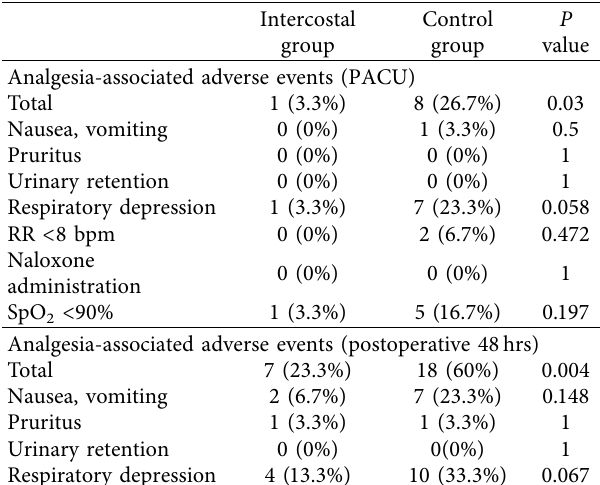
Figure 4: Anxiety scores (SCARED), depression scores (CDI), and quality of life scores (PedsQL4.0) after surgery. ∗∗ P < 0 . 01 and ∗ P < 0 . 05. SCARED, Screen for Child Anxiety-Related Emotional Disorders; CDI, Children’s Depression Inventory; PedsQL 4.0, Pediatric Quality of Life Inventory version 4.0 Generic Core Scales. Table 5: Analgesia-associated adverse events in the PACU and 2 days